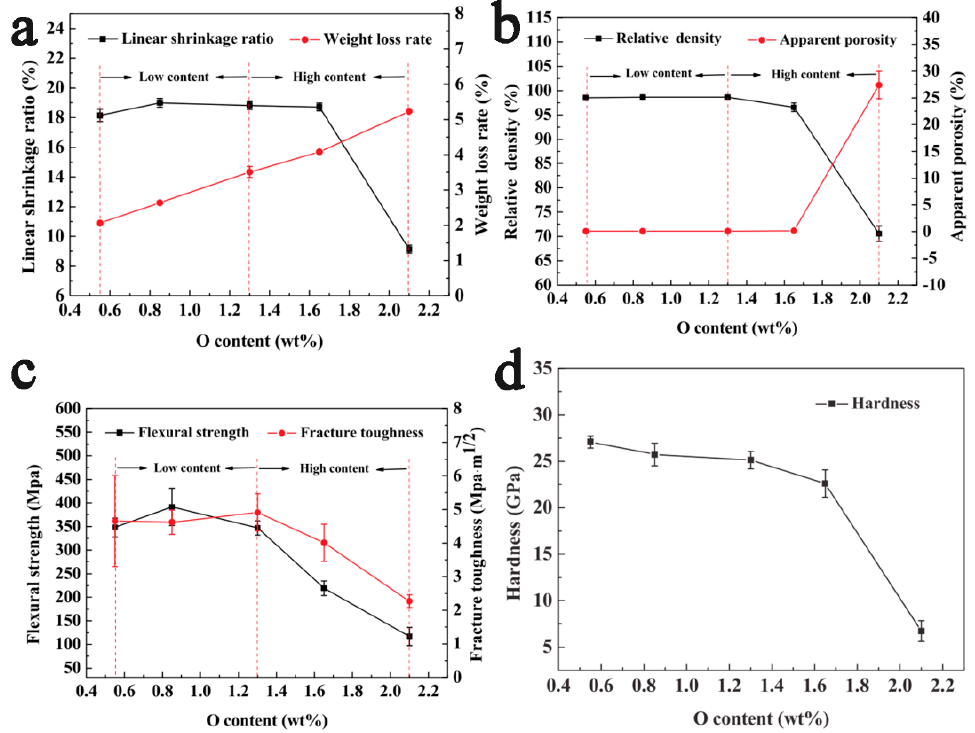
Figure 5. E ff ect of oxygen content on the mechanical properties of SiC: linear shrinking ratio and weight loss rate ( a ); relative density and apparent porosity ( b ); flexural strength and fracture toughness ( c ); hardness ( d ) [74]. Reproduced with permission from Feng D., Ceram. Int.; published by Elsevier, 2019.